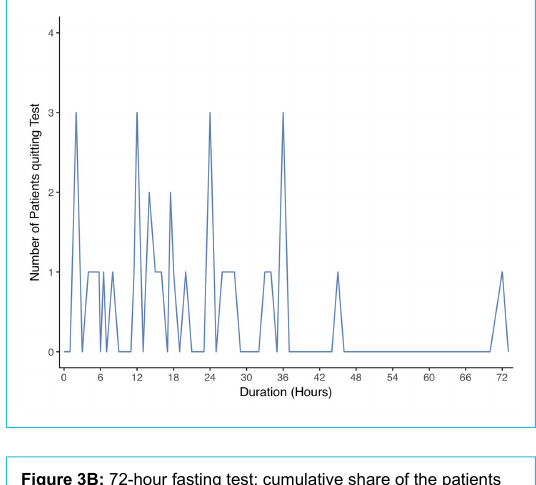
Figure 3B: 72-hour fasting test: cumulative share of the patients diagnosed with during the fasting